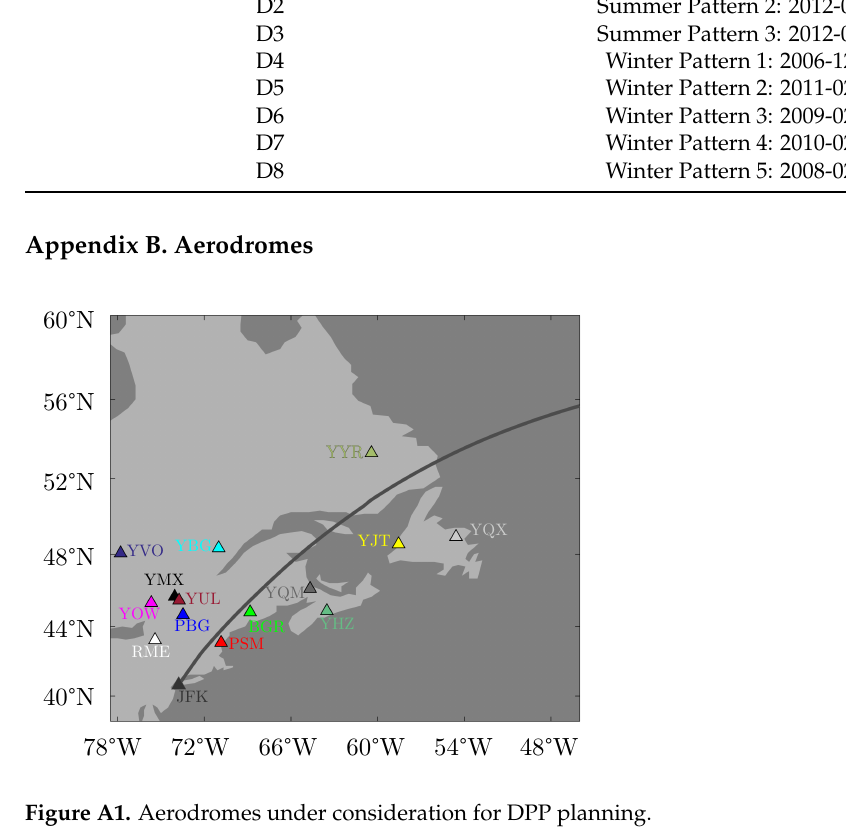
Figure A1. Aerodromes under consideration for DPP